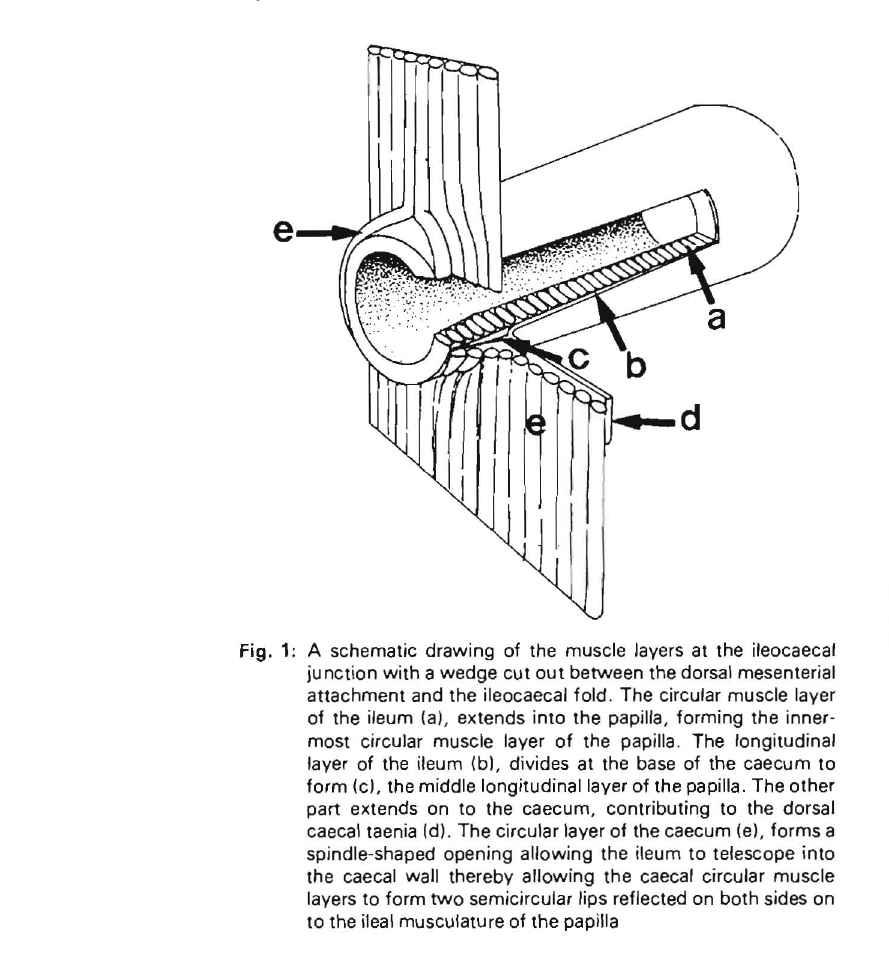
Fig. 2: The circular layer of the ileum is marked la). The longitudinal layer of the ileum Ib), divides to form the central longitudinal layer of the papilla (e), while the other portion, (dl. continues on to the caecum to mClf<e a contribution to the dorsal caecal taenia (not shown). The circular muscle of the caecum is marked Ie). Its continuation towards the tip of the papilla is in terrupted by blood vessels (f)